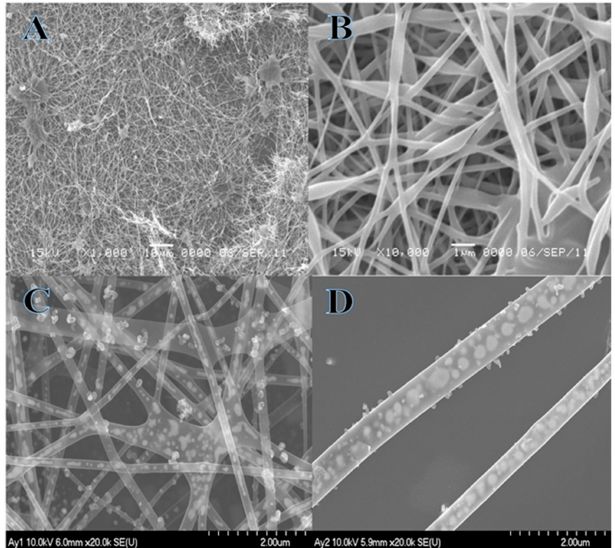
Figure 1. SEM images of electrospun nanofiber mats after drying at 60 ◦ C for 1 day ( A ) at low magnification, ( B ) at high magnification and ( C and D ) FE-SEM images of electrospun nanofiber mats after sintering at 800 ◦ C for 5 h in an Argon